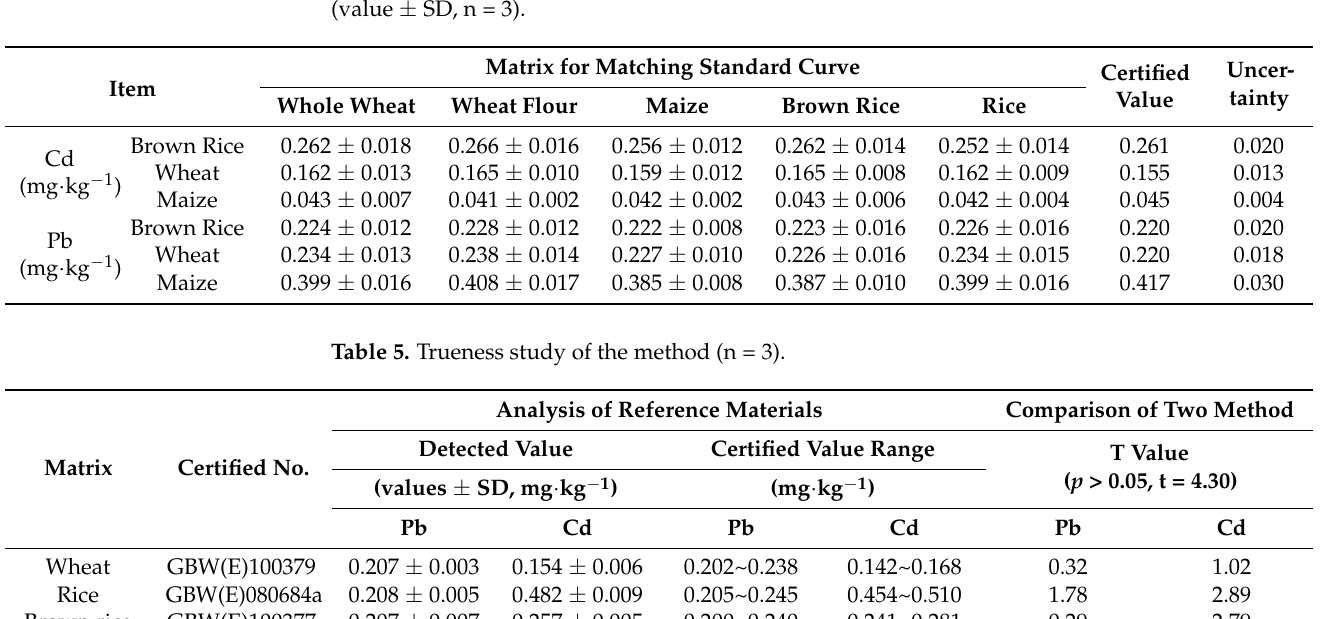
Table 4. Results of certified reference materials using different matrix matching standard curves (value ± SD, n = 3).